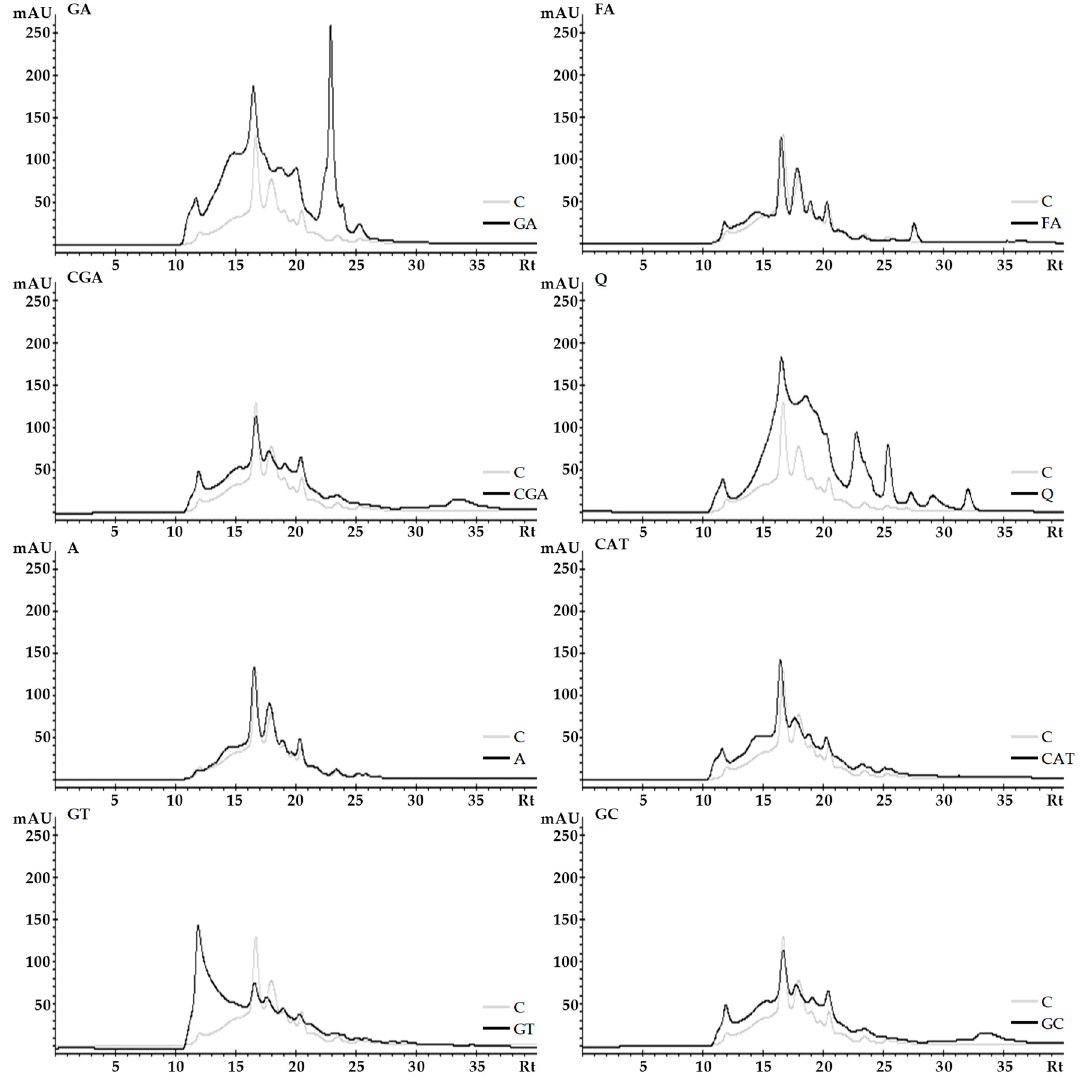
Figure 3. The effect of phenolic compounds on the SE-HPLC elution profiles of albumins. C–control sample, GA, FA, CGA, Q, A, CAT, GT, GC–protein samples after incubation with gallic acid, ferulic acid, chlorogenic acid, quercetin, apigenin, catechin, green tea, and green coffee extracts, respectively.